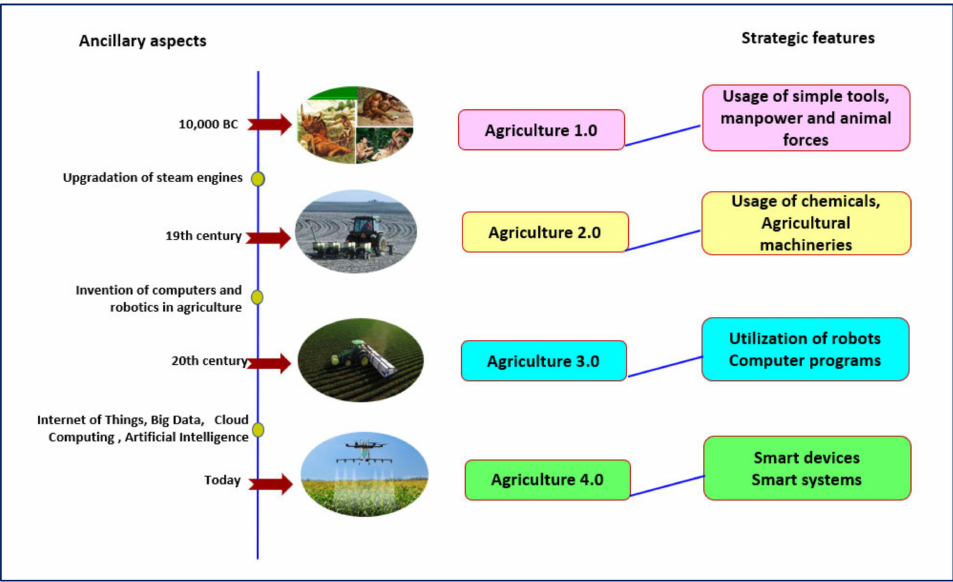
Figure 3. Agricultural decision support system